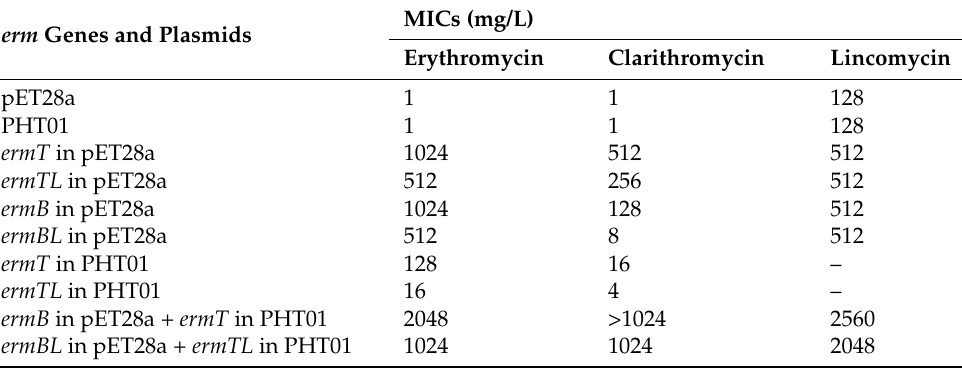
Table 3. MICs of ermB and ermT clones. ermTL and ermBL represent the ermT and ermB clones with upstream leader